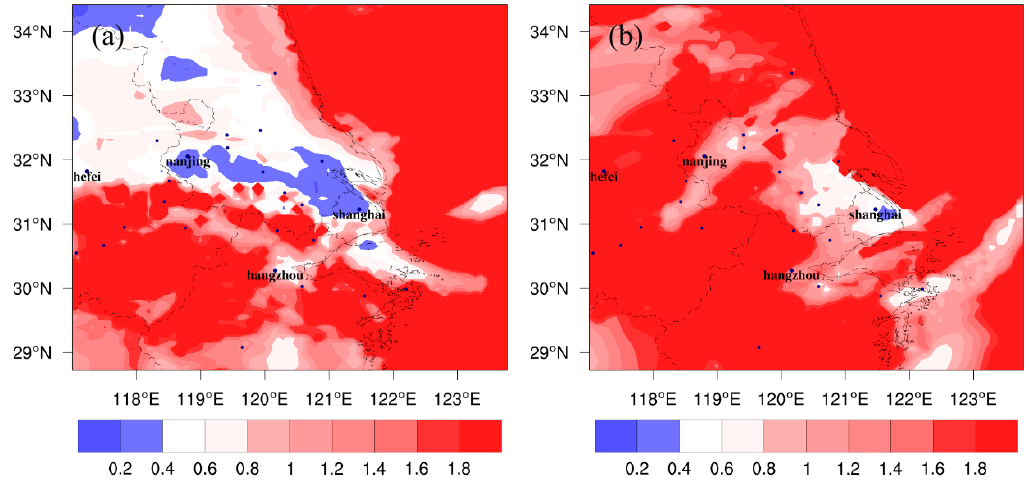
Figure 10. The spatial distributions of monthly mean H 2 O 2 / HNO 3 during the afternoon (13:00 to 16:00 LST) at the surface over the YRD region under di ff erent climate scenarios, including the distribution pattern for ( a ) PREMET and ( b ) FUTMET.